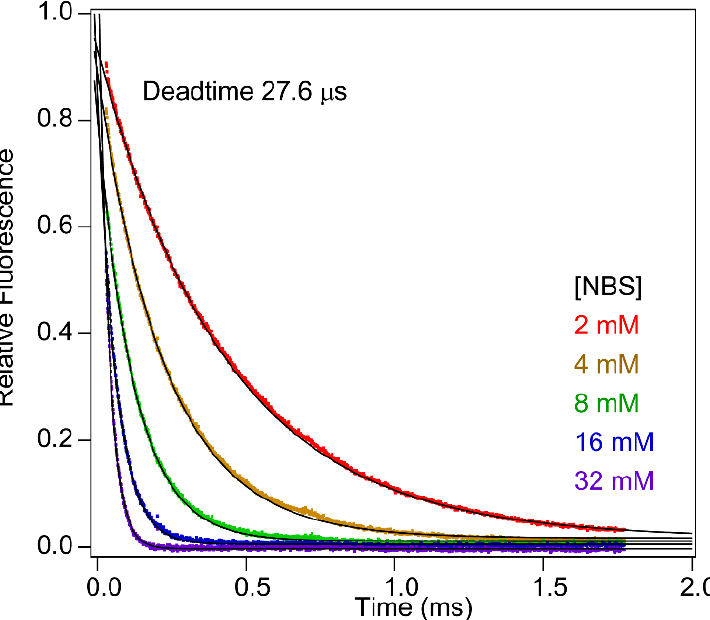
Figure 6. Dead-time calibration performed in the presence of sucrose. NBS is dissolved in 17.9% sucrose, which matches the viscosity of 8.8 M urea ( η / η 0 = 1.777). The viscosity of sucrose after 1:10 mixing (16.2%, η / η 0 = 1.663) matches that of 8 M urea.